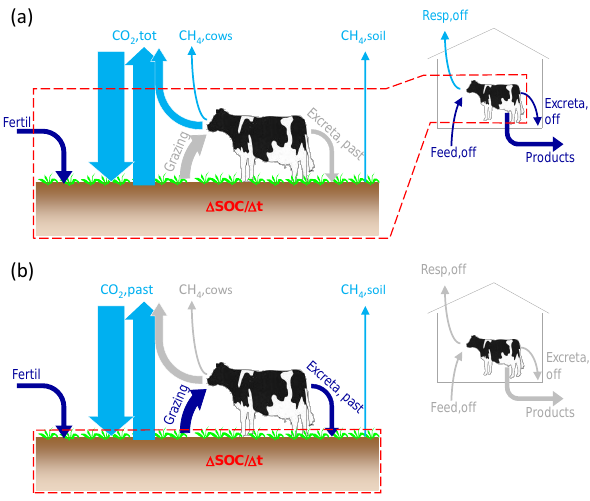
Figure 2. Illustration of the two approaches to determine the net ecosystem carbon budget of a dairy pasture using different system boundaries (dashed red line): (a) NECB tot using system boundaries including the cows; (b) NECB past using system boundaries exclud- ing the cows. Relevant carbon fluxes through the system boundaries are marked in blue (gaseous fluxes: light blue, liquid/solid fluxes: dark